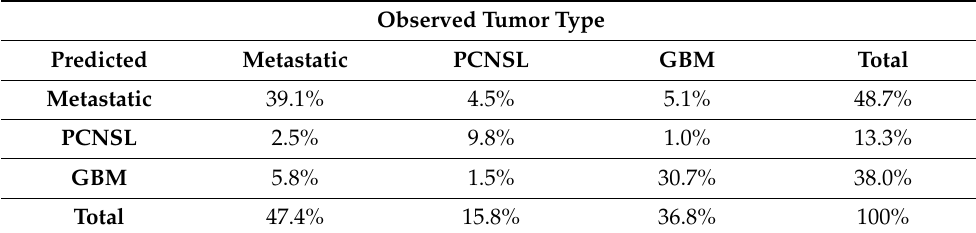
Table 5. Confusion matrix for the best performing model (GBRM fit using the full